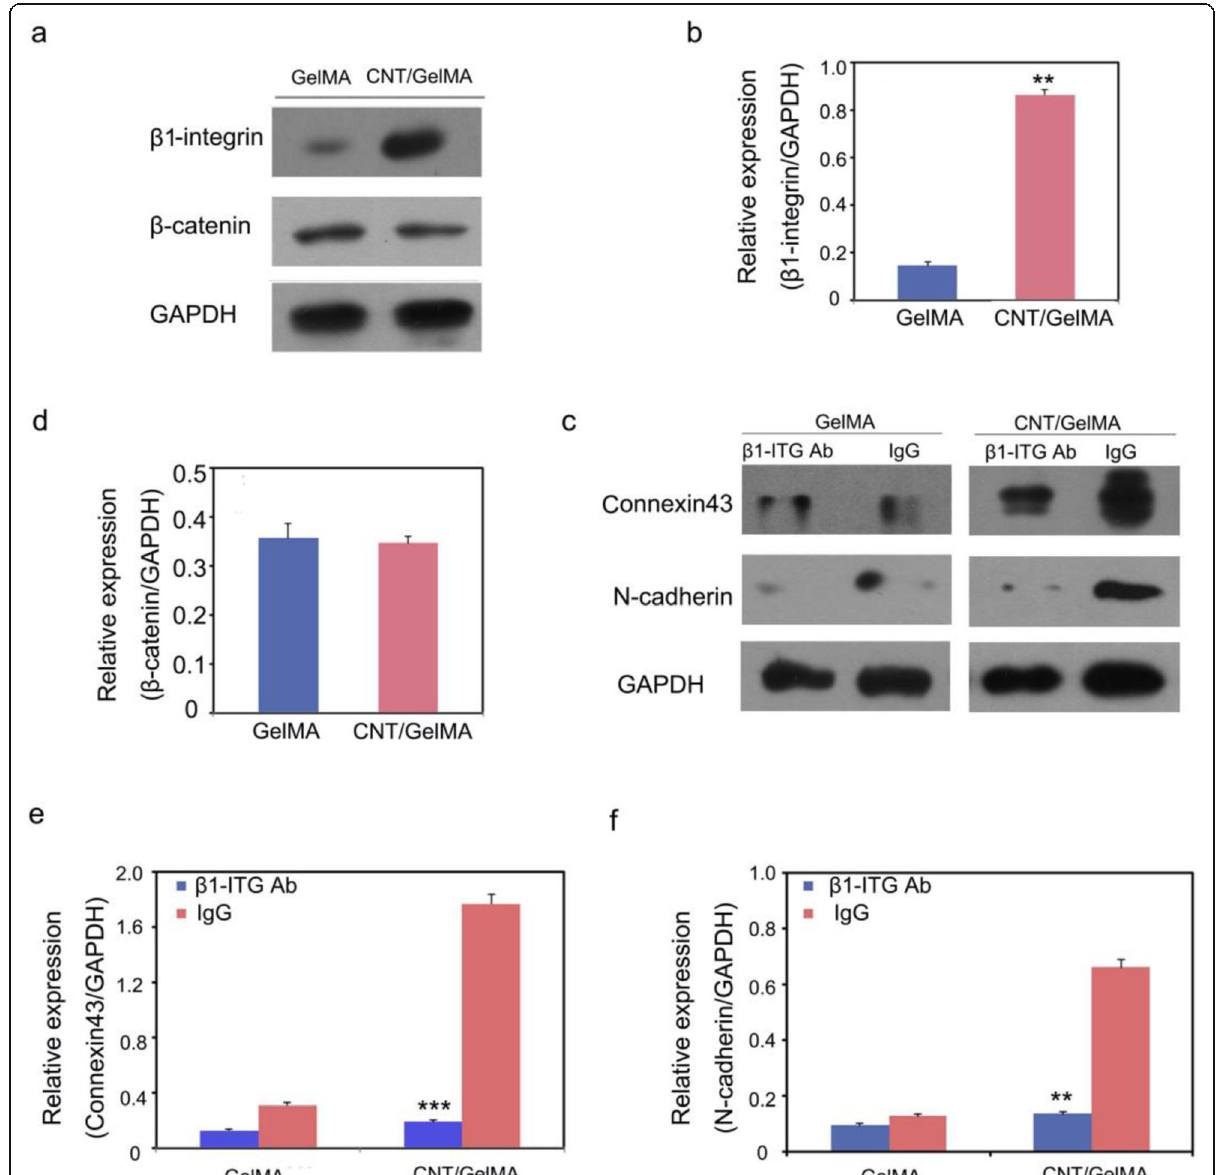
Fig. 10 Comparison of relative expression of β 1-integrin, β -catenin, Cx43 and NC between GelMA group and CNT/GelMA group. a , b , d : Western blot showed the markedly increased expression of β 1-integrin on CNT/GelMA hydrogels compared to those on GelMA hydrogels while the expression of β -catenin were similar in the two groups. c , e , f : Western blot showed that anti- β 1-integrin antibody (Ab) significantly suppressed the increase of Cx43 and NC expression in the CNT/GelMA hydrogels whereas no remarkable changes were noted on the control group. Reproduced with permission [114]. Copyright (2017), Elsevier